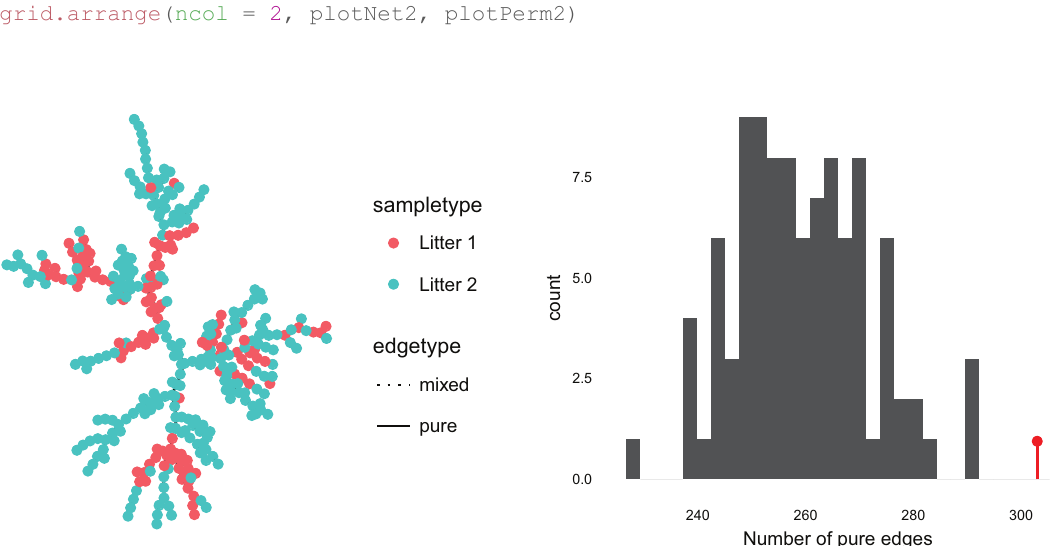
Figure 23. The graph and permutation histogram obtained from the minimal spanning tree with Jaccard similarity.